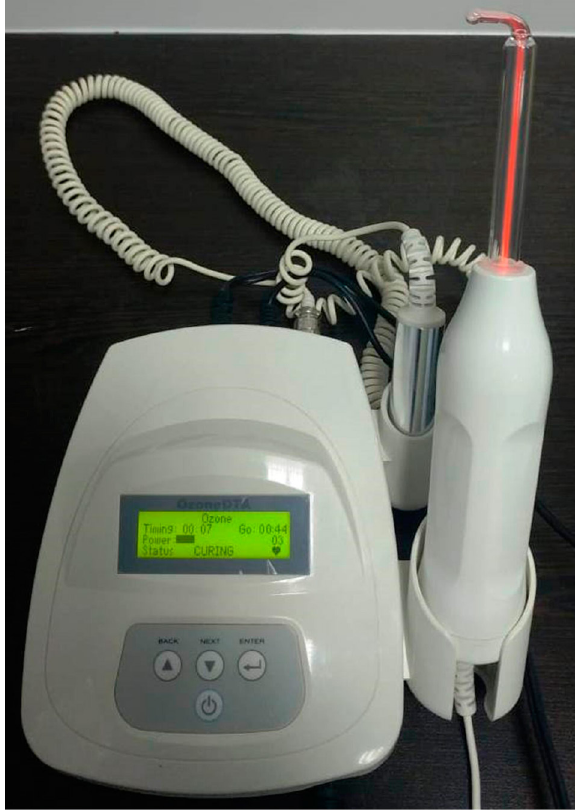
Figure 2- Ozone device used in the